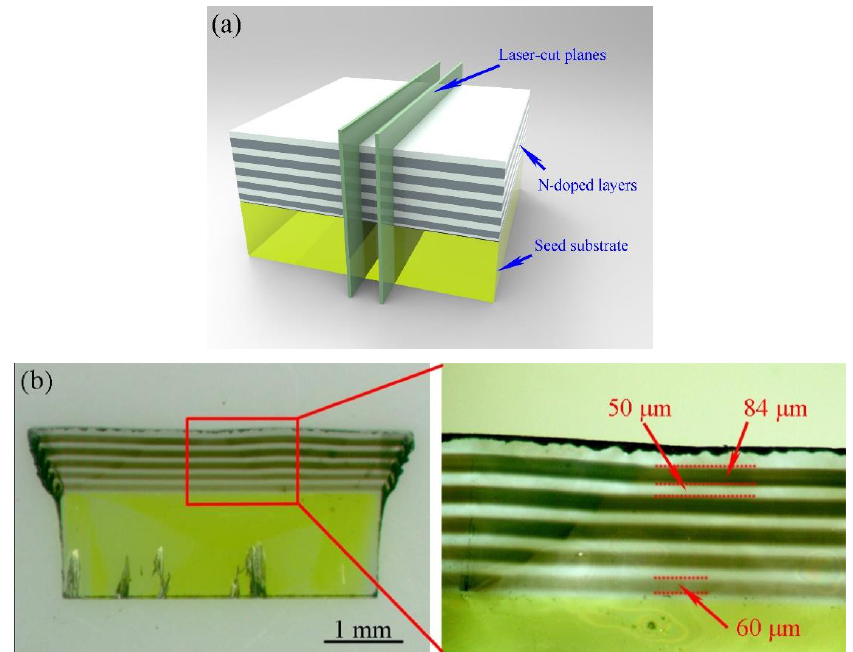
Figure 2. ( a ) Schematic of laser cutting of the nitrogen-doped multilayers grown on the HPHT seed substrate. The two cutting planes perpendicular to the surface are shown in light green. ( b ) Optical image of the 400- µ m-thick cross section slice obtained after laser-cutting and polishing of the lateral